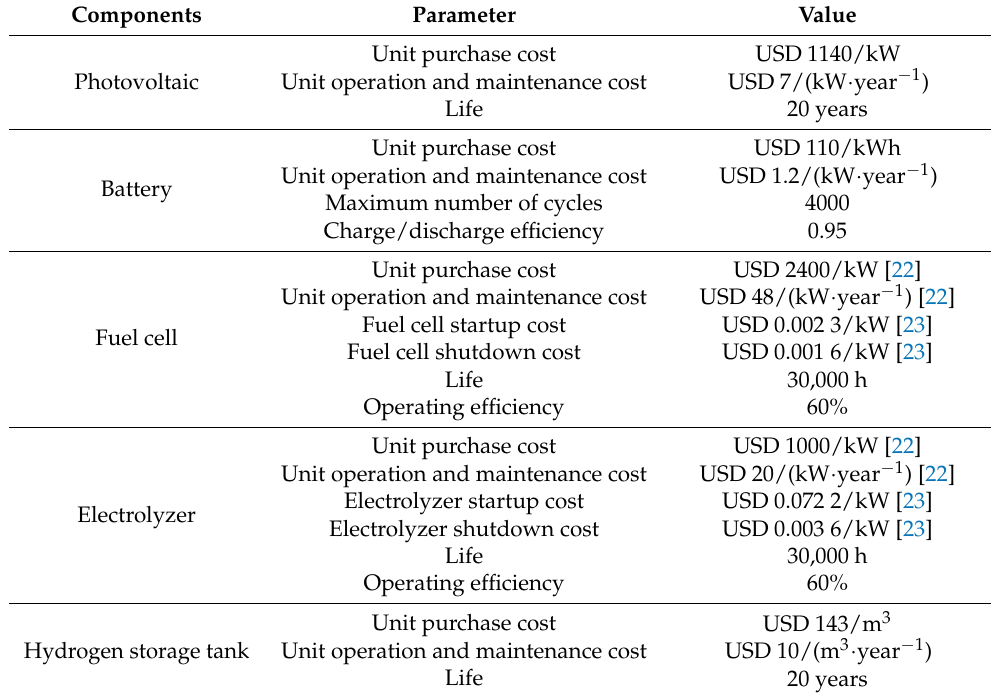
Table 1. Parameters of simulation.